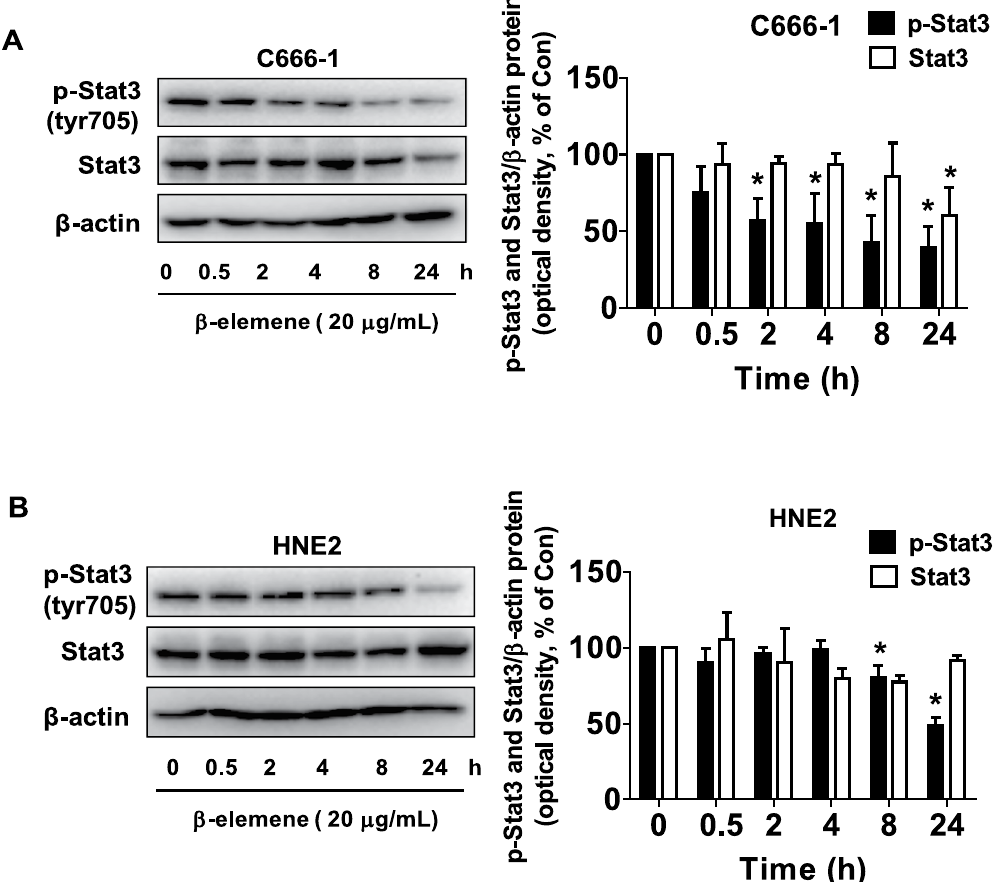
Figure 2. β -elemene reduced the phosphorylation of Stat3. ( A,B ) C666-1 ( A ) and HNE2 ( B) cells were treated with β -elemene (20 μ g/mL) in the indicated times, and cell lysate was harvested and the expression of the phosphorylated or total protein of Stat3 was measured by Western blot analysis using corresponding antibodies. β -actin was used as loading control. The figures are representative cropped gels/blots that have been run under the same experimental conditions. The bar graphs represented the densitometry results of p-Stat3, Stat3/ β -actin as mean ± SD of at least three separate experiments. * Indicates significant difference from the untreated control cells (P <